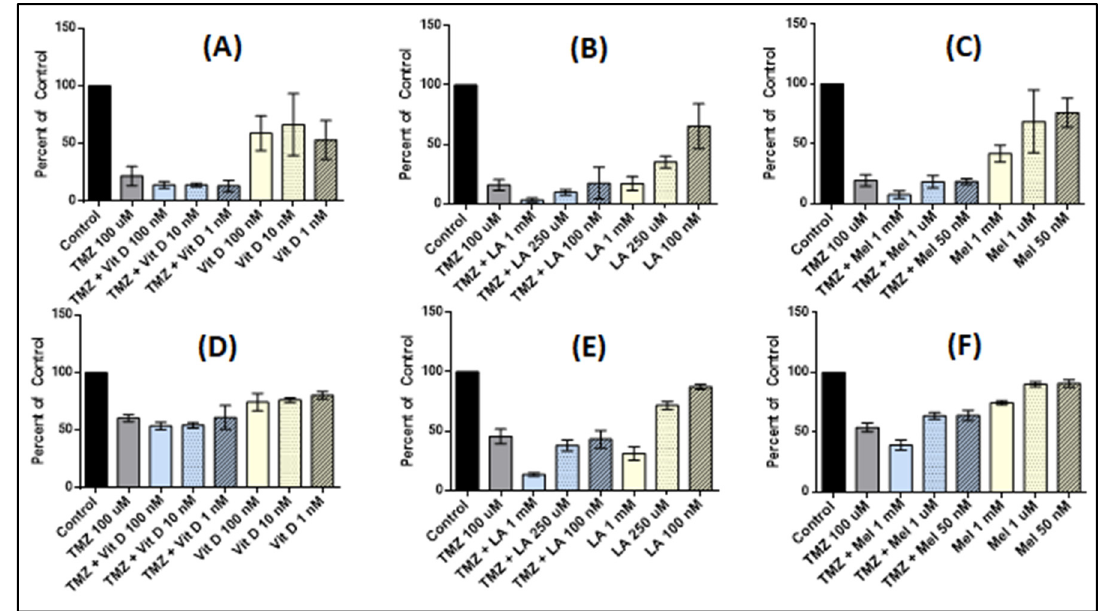
Figure 3. Cell proliferation of U87 ‐ MG and MU1454 measured via the MTT assay after serial 72 h treatments with antioxidants (Vitamin D [Vit D], Lipoic Acid [LA], or Melatonin [Mel]), followed by combined 72 h treatment with antioxidants and TMZ at 100 uM. Dose of TMZ is constant at 100 uM, while dose of antioxidant varies and is indicated on the graph. ( A ) U87 ‐ MG cells after treatment with Vitamin D at 1 nM, 10 nM, and 100 nM. ( B ) U87 ‐ MG cells after treatment with Lipoic acid at 1 mM, 250 uM, and 100 nM. ( C ) U87 ‐ MG cells after treatment with Melatonin at 1 mM, 1 uM, and 50 nM. ( D ) MU1454 cells after treatment with Vitamin D at 1 nM, 10 nM, and 100 nM. ( E ) MU1454 cells after treatment with Lipoic Acid at 1 mM, 250 uM, and 100 nM. ( F ) MU1454 cells after treatment with melatonin at 1 mM, 1 uM, and 50 nM. Error bars represent the 95% confidence interval.